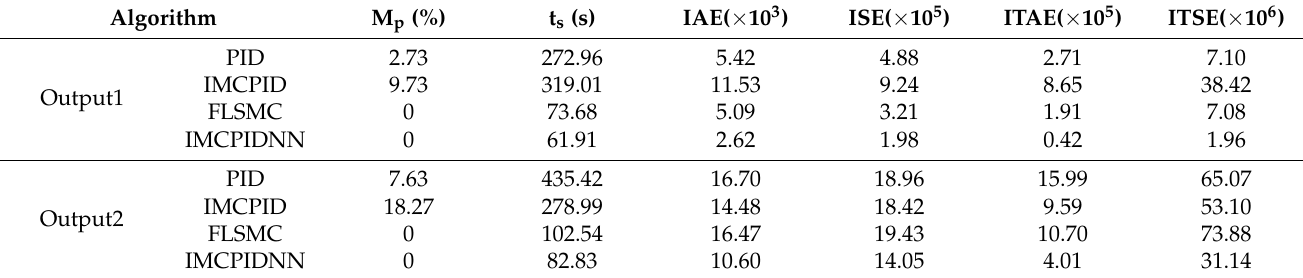
Table 3. Performance comparison of the four algorithms used for concurrent step